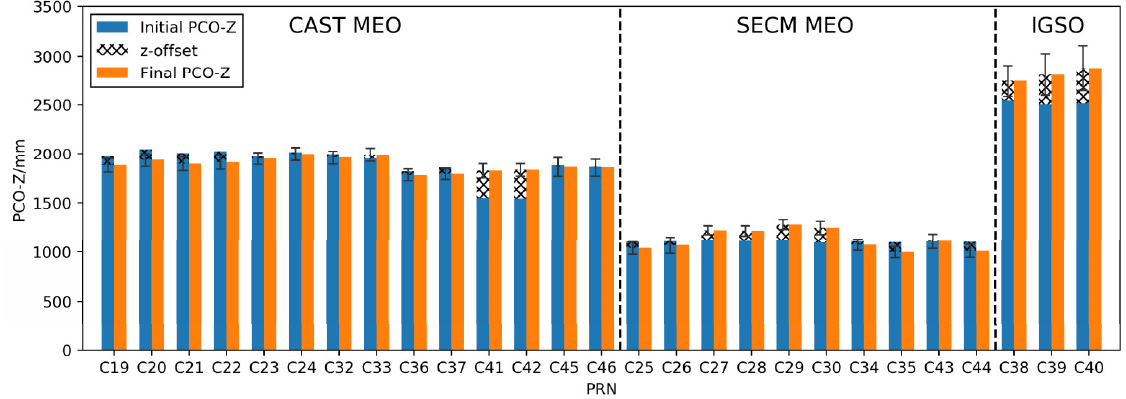
Figure 6. The initial PCO-Z, z-offsets, and the final PCO-Z. The z-offset is the correction of the initial PCO-Z, and the sum of the z-offset and initial PCO-Z is the final PCO-Z.